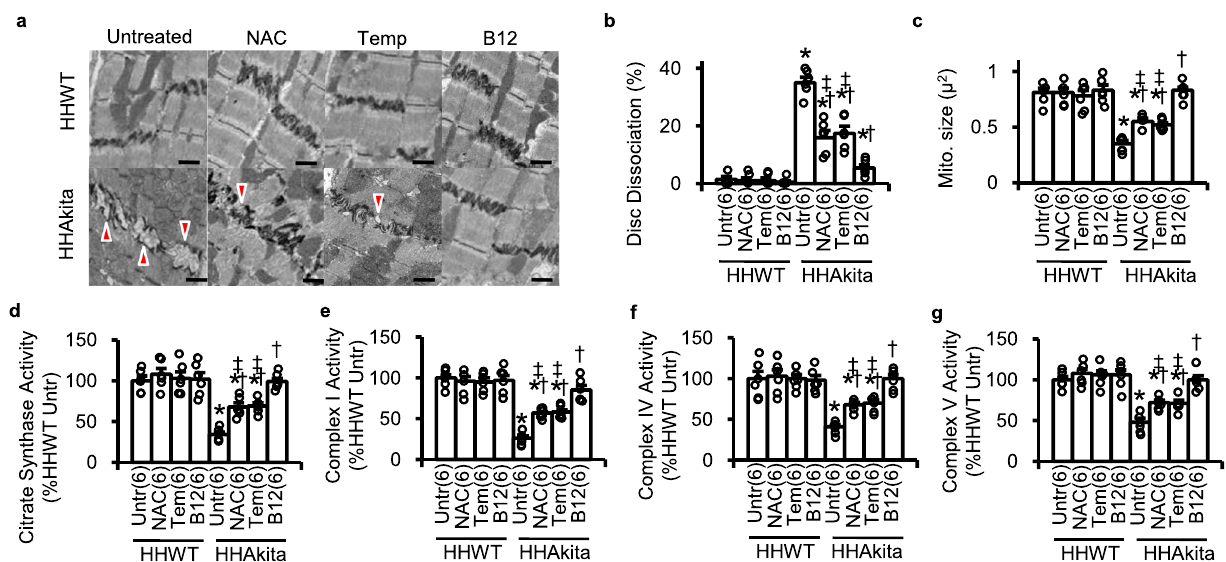
Fig. 4 Effects of orally administered NAC, tempol (Tem), and B12 on the ultrastructure and mitochondrial function in the heart. a Representative images of the intercalated disc in the heart of HHWT ( Elmo1 H/H Ins2 + / + ) and HHAkita ( Elmo1 H/H Ins2 Akita/ + ) mice in the transmission electron microscopy. Arrowheads indicate the dissociation of intercalated discs. Scale bar = 1 μ m. b Proportion of the dissociated intercalated discs. c Apparent size of mitochondria (mito.) were scored from at least 30 mitochondria in each animal. d Citrate synthase activity in the heart. e Mitochondrial complex I activity. f Mitochondrial complex IV activity. g Mitochondrial complex V activity. Data are expressed as means ± standard errors. N = 6 in each group. * P < 0.05 vs. untreated (Untr) HHWT mice by Tukey – Kramer Honestly Signi fi cant Differences test after one-way ANOVA; † P < 0.05 vs. untreated HHAkita mice; ‡ P < 0.05 vs. B12-treated HHAkita